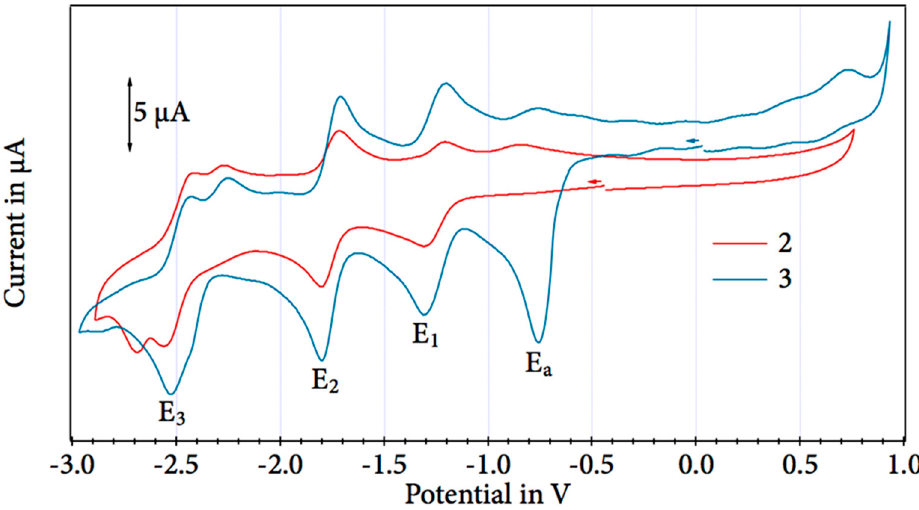
Figure 3. CVs of compounds 2 and 1 (10 − 3 M) in DMSO with 0.1 M [NBu 4 ][CF 3 SO 3 ]. The direction of the arrows indicates the direction of the scan. Table 1. Formal electrode potentials (V vs . FeCp 2 ) and peak-to-peak separations ( Δ Ep in mV) in 0.1